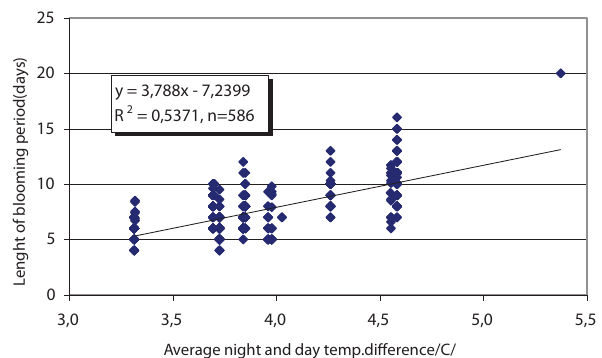
Figure 6. Relationship between the length of blooming and the average